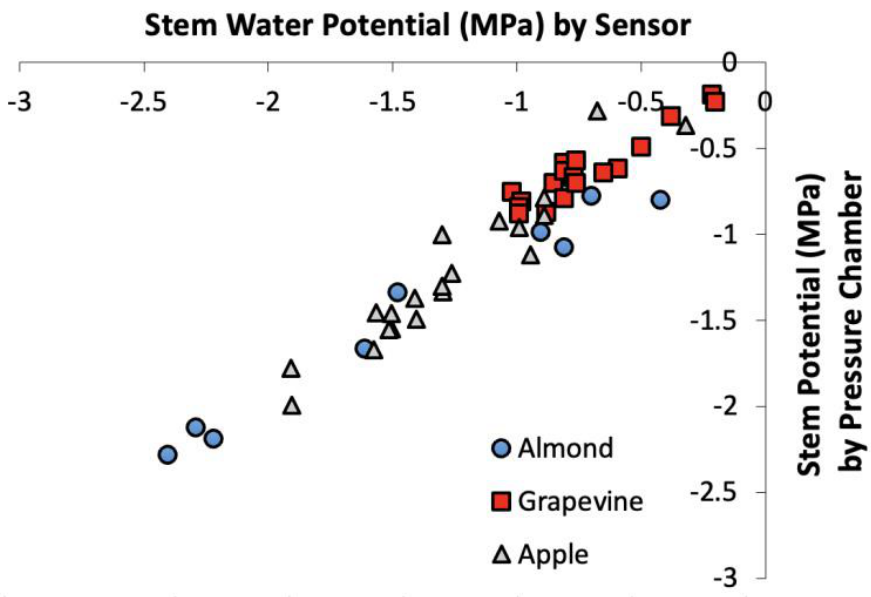
Figure 8. Relationships of early morning and mid-day stem water potentials conducted in the field between the microtensiometer sensor and the Scholander Pressure Chamber on separate studies on almond and grape in California and apple in New York. The figure is reproduced from Lakso et al., 2022 with the addition of the previously unpublished apple data.